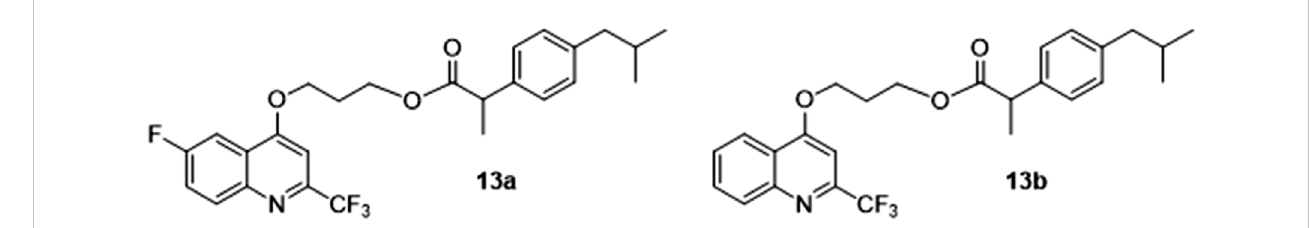
FIGURE 11 Ibuprofen-quinoline hybrids with anti-in fl ammatory activity.